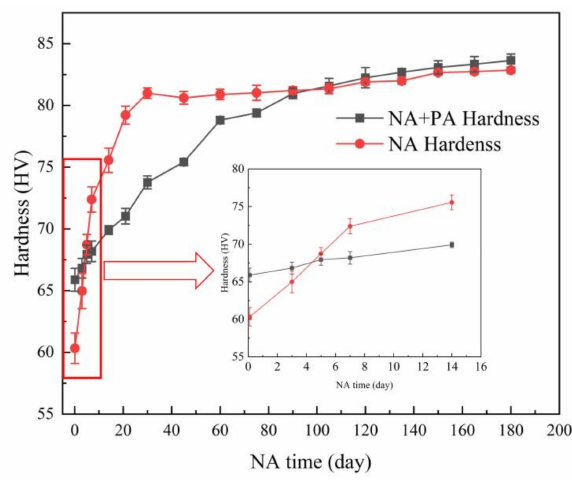
Figure 4. Hardness change curves of AA6014 alloy with and without pre-aging (PA) treatment within six